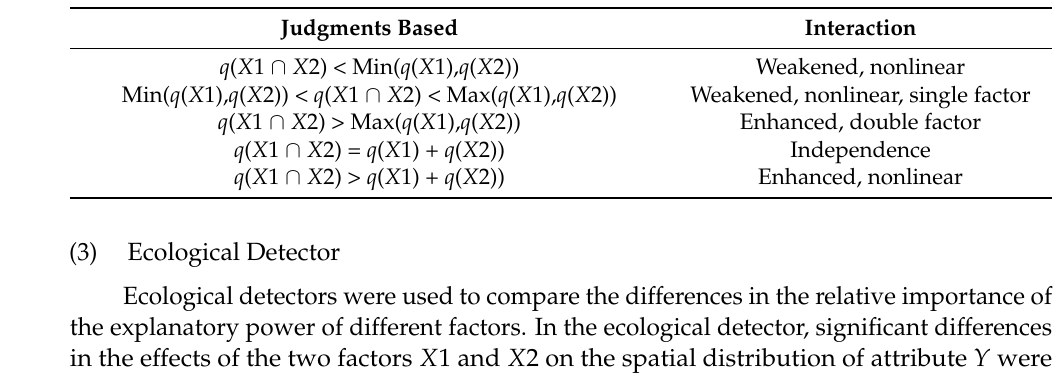
Table 2. Type of the interaction detector